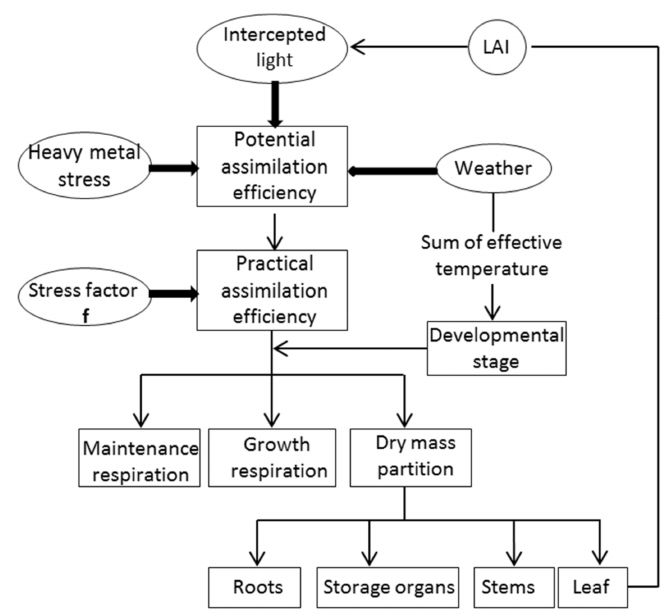
Figure 3. Simplified structure of the improved WOFOST model with stress factor f